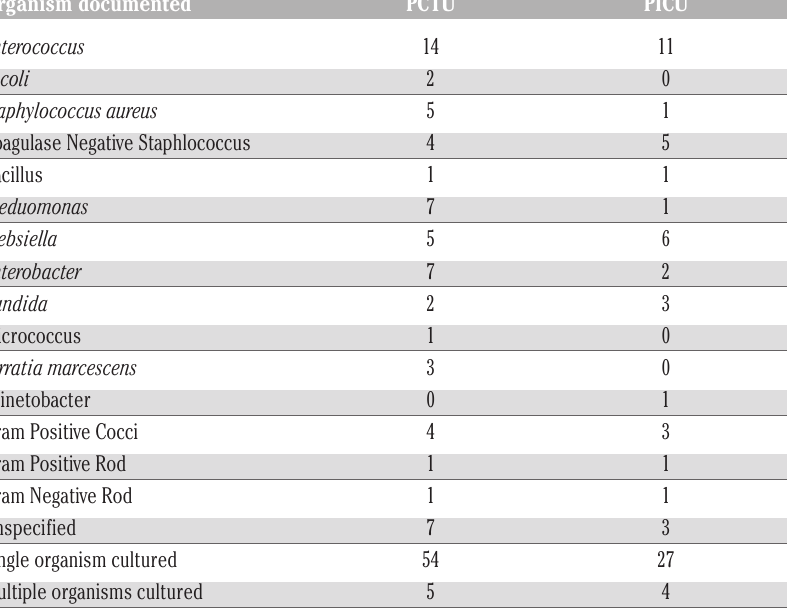
Table 2. The table displays the organisms cultured as specified in the patient chart in the Pediatric Intensive Care Unit and Pediatric Cardiothoracic Intensive Care Unit as well as whether a Central line associated bloodstream infections cultured a single organism or multiple